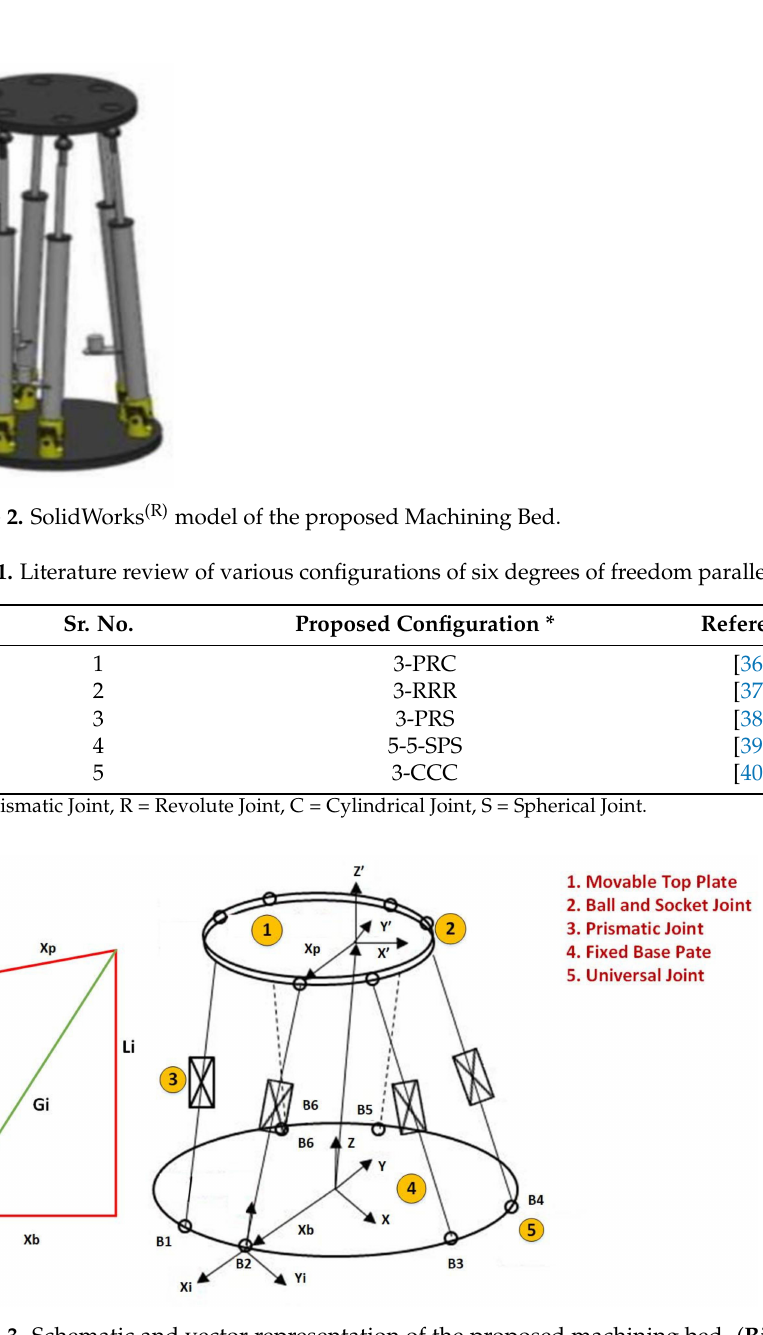
Figure 3. Schematic and vector representation of the proposed machining bed. ( Right ) schematic representation of kinematic chain connections and angle distribution. ( Left ) the schematic diagram for the ith leg of the